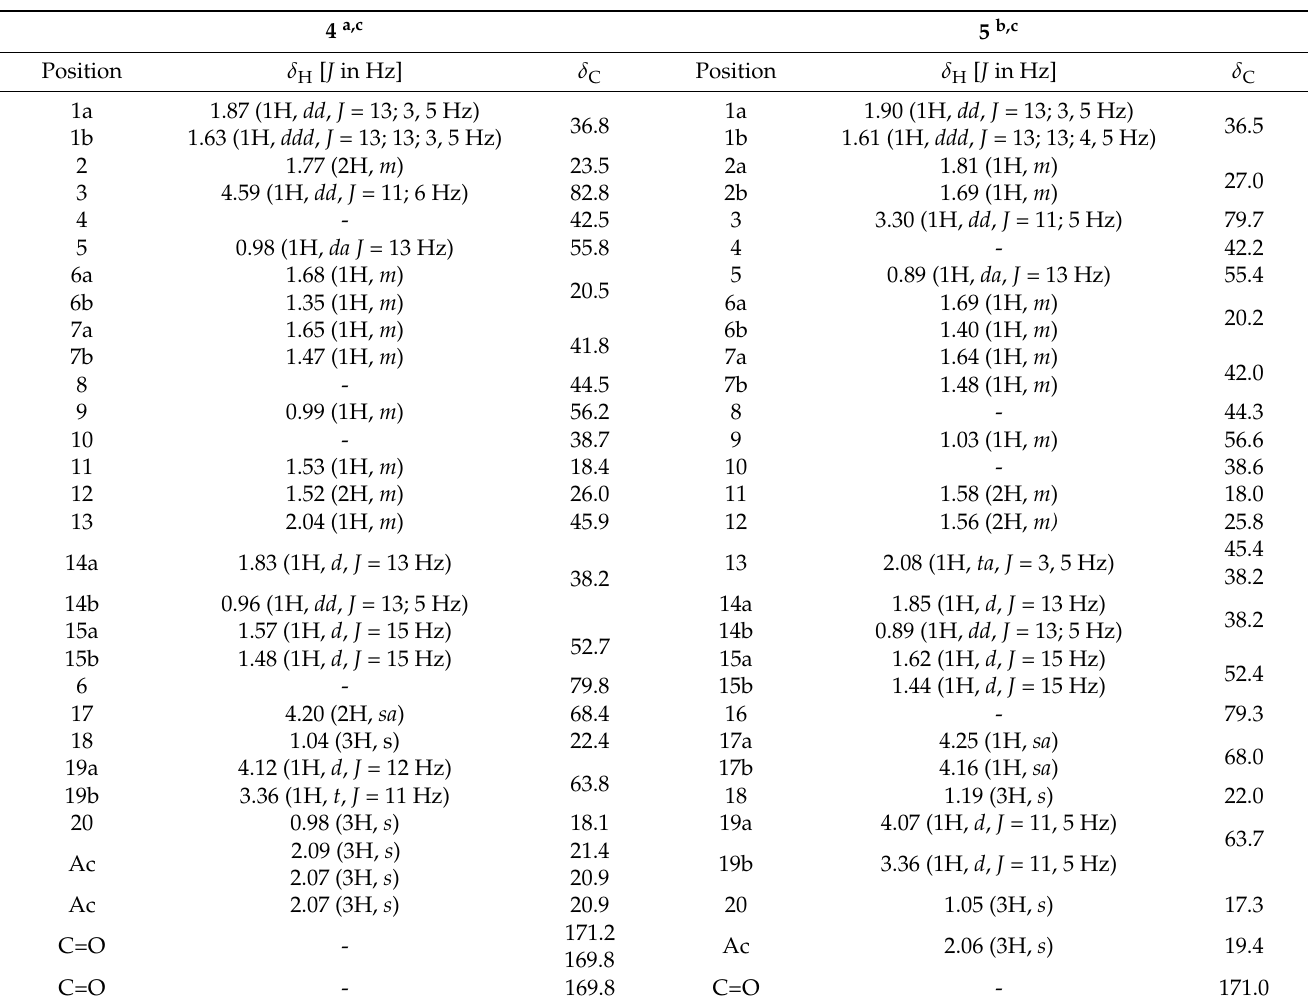
Table 1. 1 H NMR and 13 C NMR spectroscopic data for compounds 4 and 5